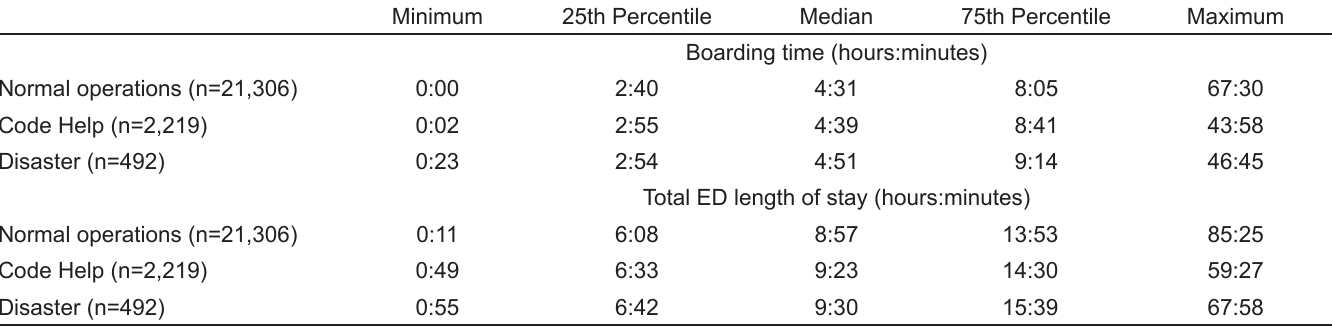
Table 2. Boarding time and total emergency department (ED) length of stay by department status at the time of admission decision.